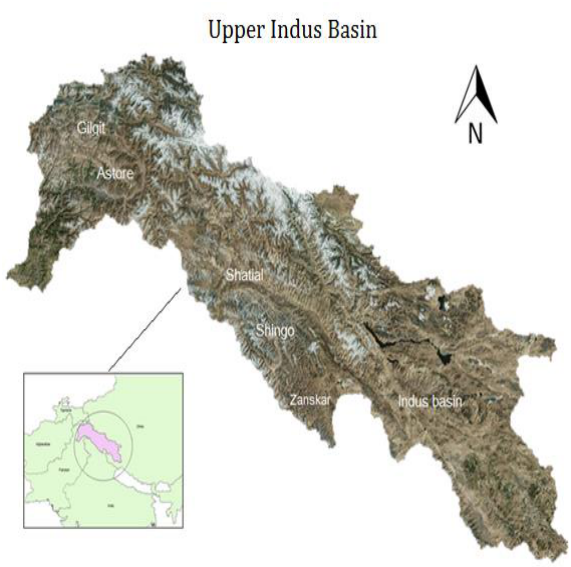
Figure 1: Study Area showing the location of Upper Indus